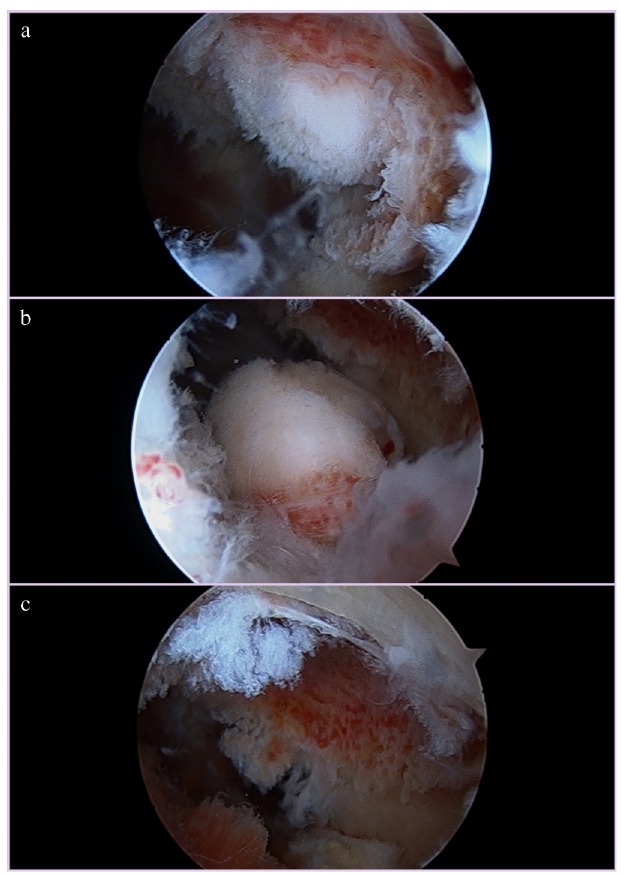
Figure 2. Arthroscopic images showing identi fi cation of the lesion after removal of synovium and thin cortical shell (a) removal of the nidus and surrounding sclerosis, (b) and clear base after removal of the lesion.